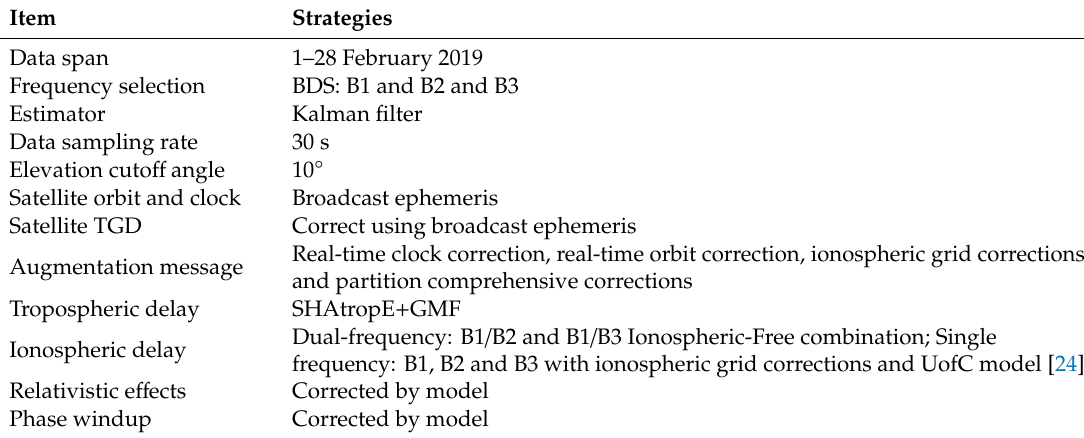
Table 4. PPP strategies based on BDS SBAS